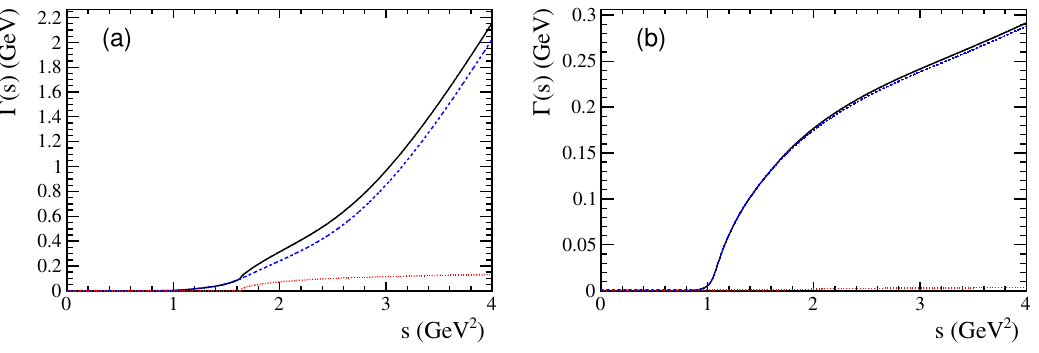
Figure 17 . Energy-dependent width for the K 1 (1270) (a) and K 1 (1400) (b) resonances. The total width is shown in black (solid), while the partial widths into the channels K(cid:25)(cid:25) and K! are shown in blue (dashed) and red (dotted), respectively.